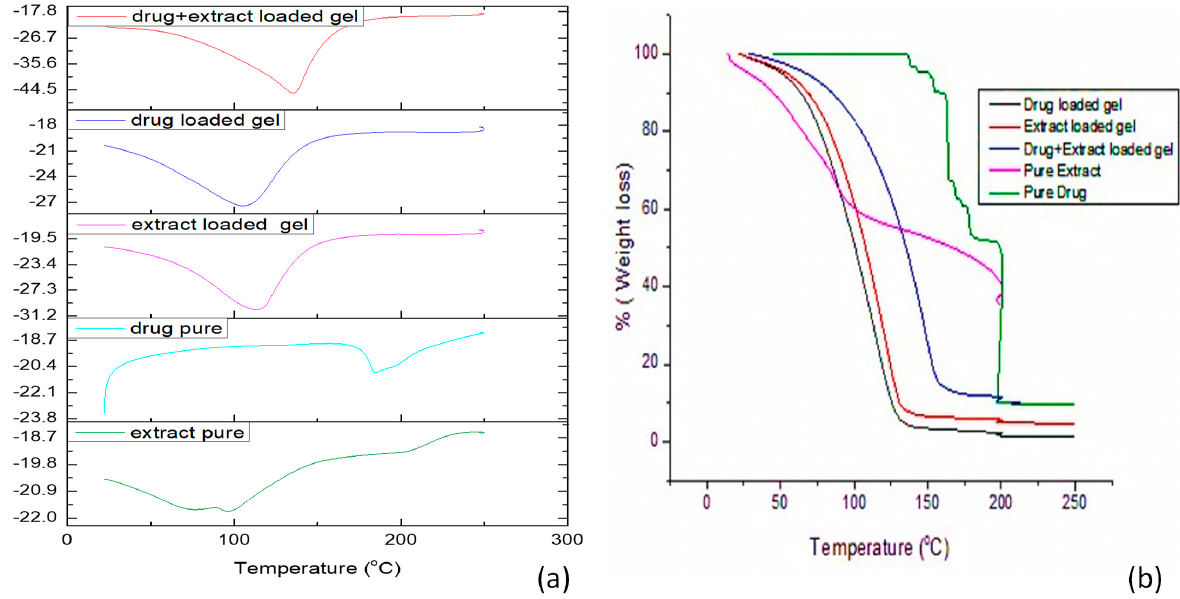
Figure 3. DSC ( a ) and TGA ( b ) curves of the active ingredients and prepared formulations.